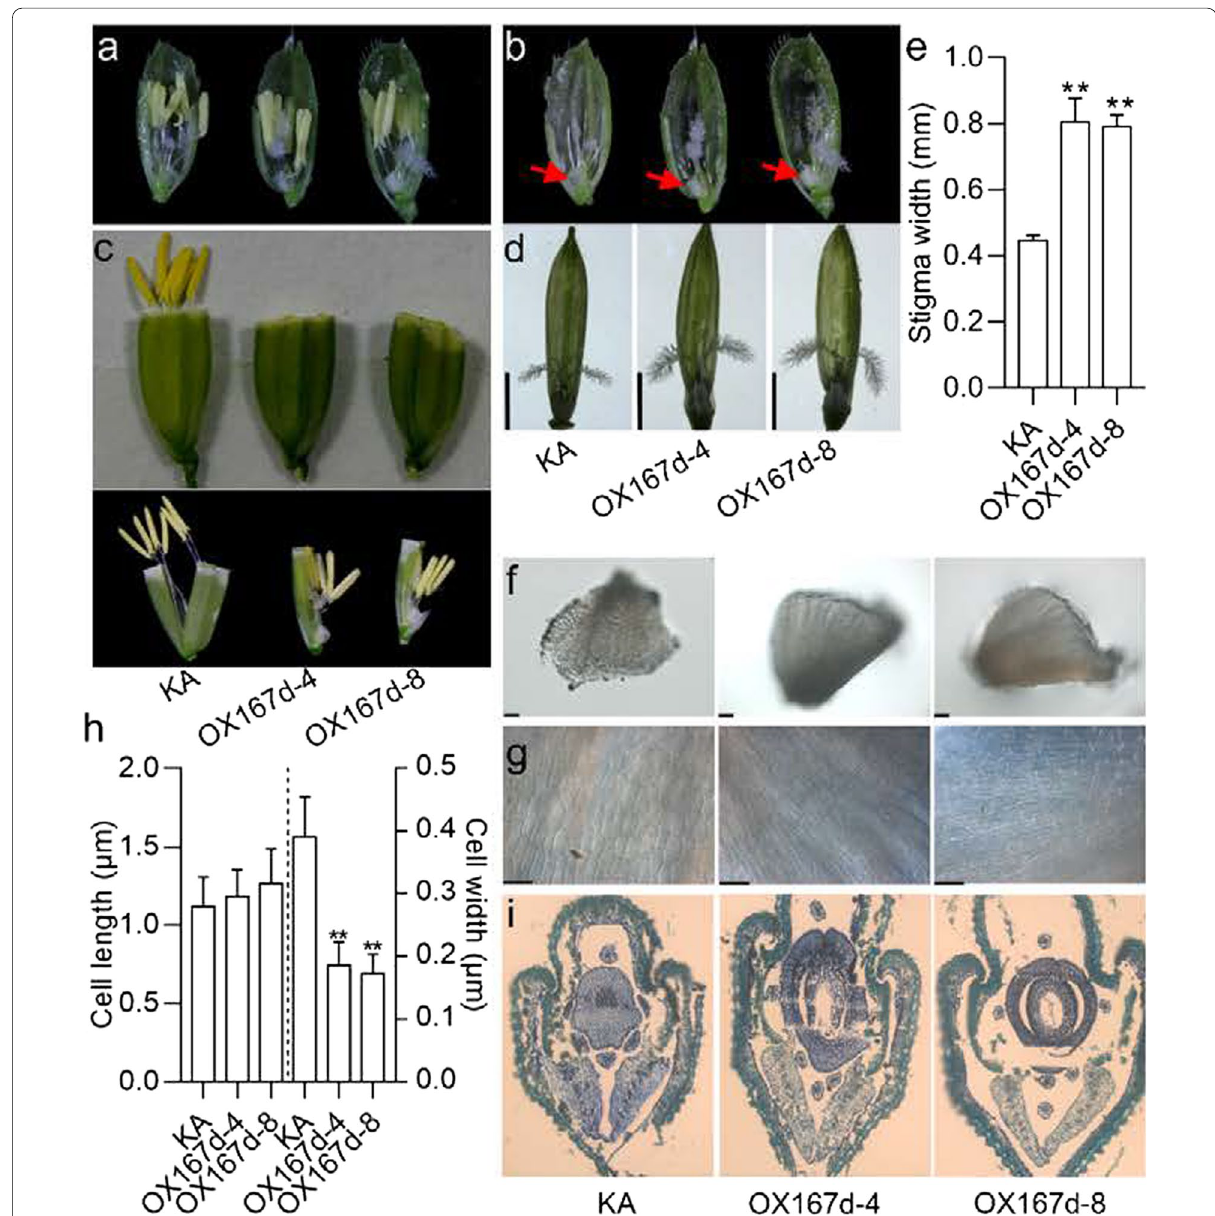
Fig. 2 Phenotypic analysis of the floral organs in OX167d. a Overview of the inner floral organs in KA and OX167d lines. b Overview of the stigmas and lodicules. The stamen was removed from ( a ). Red arrows indicate lodicules. c The phenotype of the filament elongation in the indicated lines. d Close‑up view of the stigmas. Bars, 2 mm. e Comparison of the stigma width in the indicated lines. Error bars indicate the standard deviation (SD) (n 10). **P < 0.01 (Student’s t ‑test). f Close‑up view of the lodicules in KA and OX167d. Bars, 100 μm. g Cell morphological features of lodicules in = KA and OX167d. Bars, 50 μm. h Comparison of the cell length and cell width from ( g ). Error bars indicate standard deviation (SD) (n (Student’s t ‑test). i Transverse section of the flowers in KA and